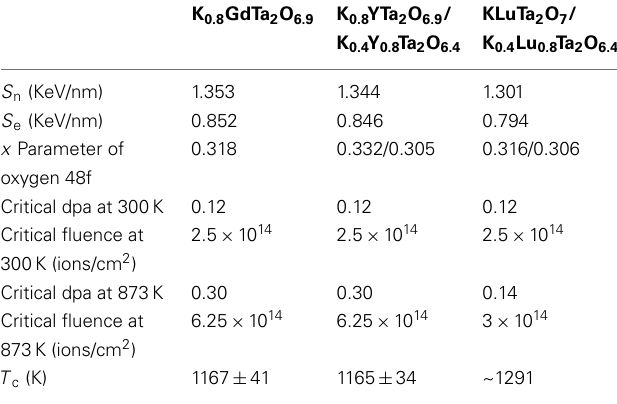
Table 3 |The nuclear stopping power ( S n ) and electron stopping power ( S e ) of the incident 1MeV Kr 2 + in different K x Ln y Ta 2 O 7-v samples; x parameters of oxygen 48f; critical amorphization doses at 300 and 873K and the critical amorphization temperatures of the tantalate pyrochlores